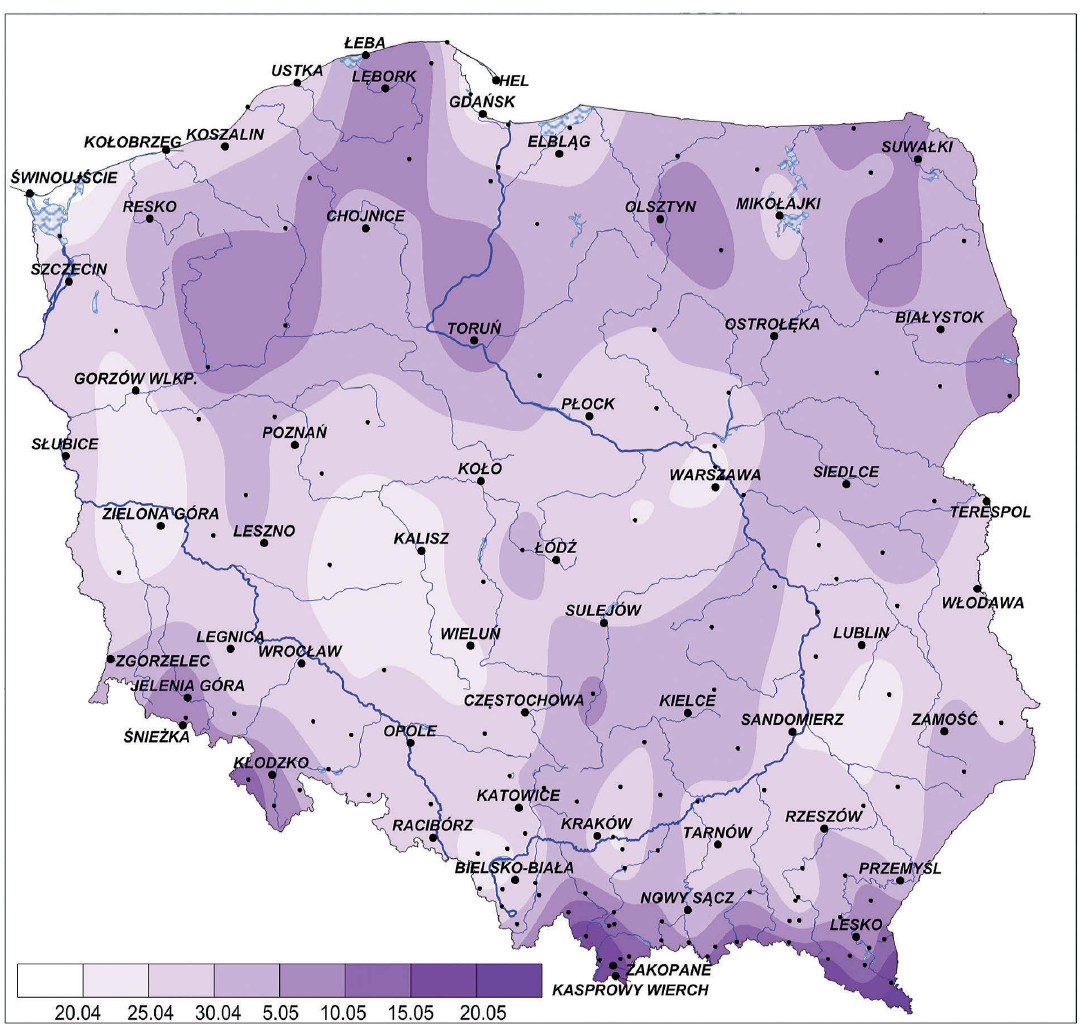
Fig. 1. Average date (day.month) of last spring